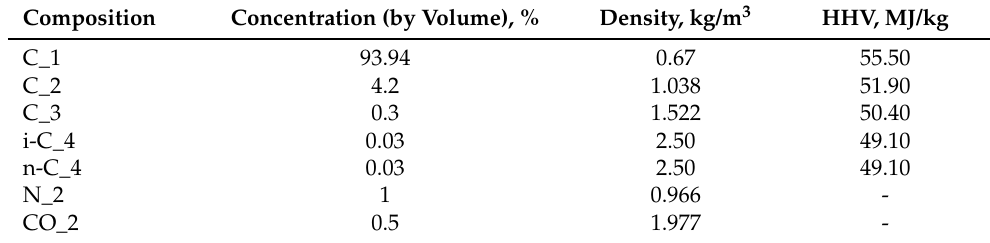
Table 1. Composition properties of natural